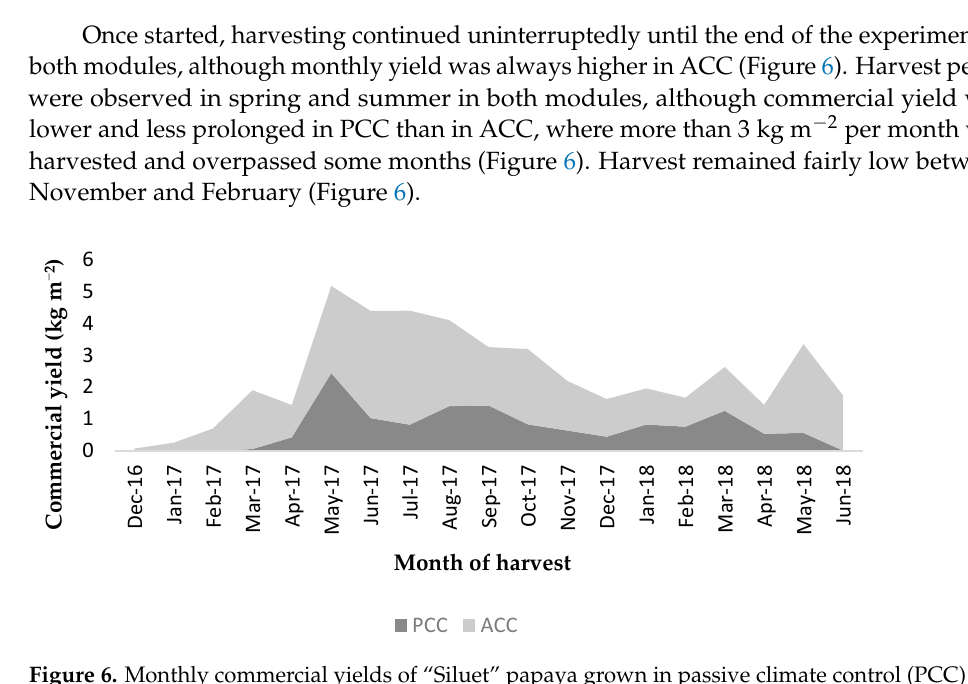
Figure 6. Monthly commercial yields of “Siluet” papaya grown in passive climate control (PCC) and active climate control (ACC) modules.